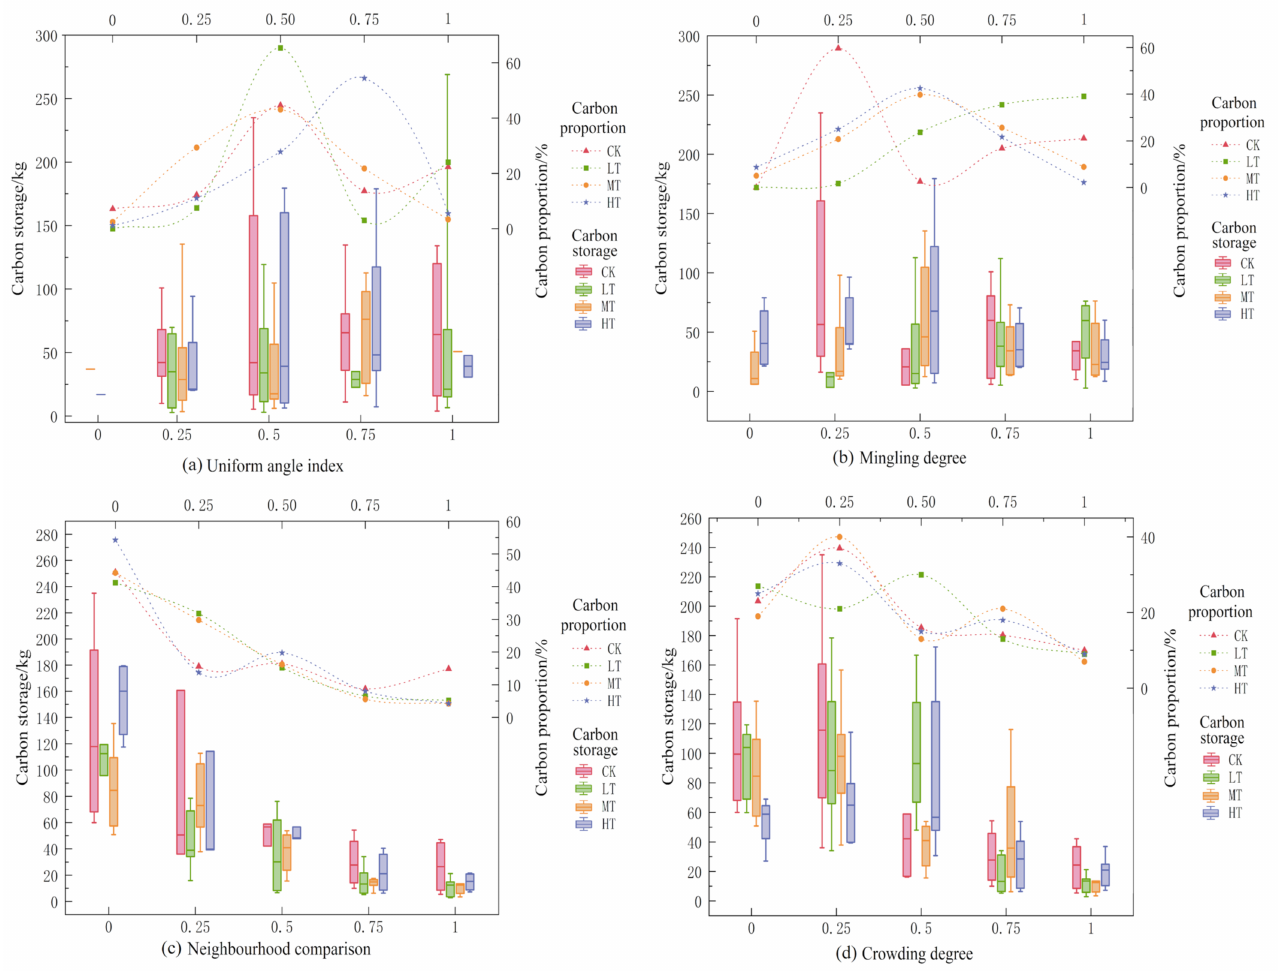
Figure 6. The carbon proportion of spatial structure index under different treatments. Pictures ( a – d ) represent uniform angel index, mingling degree, neighbourhood comparison and crowing degree,